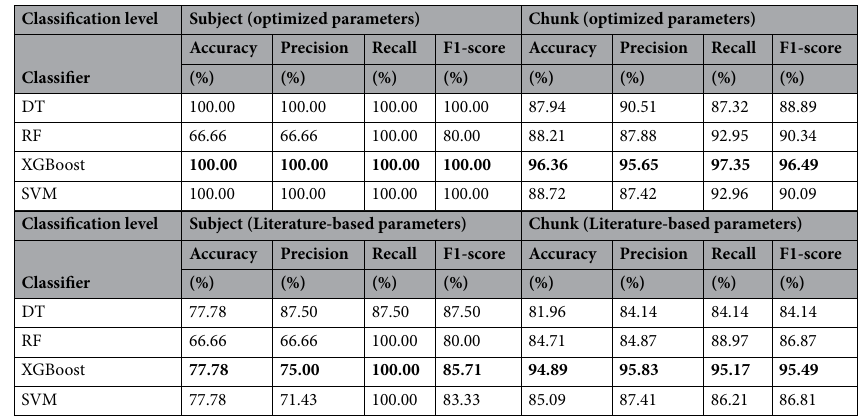
Table 4. Performance evaluation of the proposed method for the optimized and non-optimized models. Significant values are in